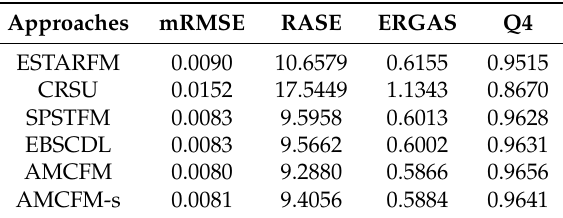
Table 6. Global quality metrics in image 1.